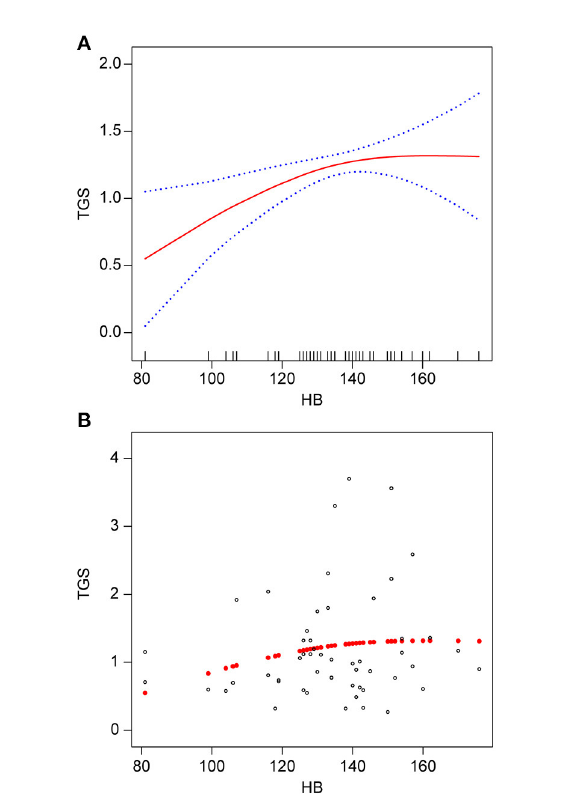
FIGURE3 Association between Hb (g/L) and TGs (mmol/L) in patients with hemorrhagic MMD. (A) smooth fitted curve of Hb and TGs, (B) scatter plot for the distribution of Hb and TGs. The solid red line represents the smooth curve fit between the variables. The blue bands represent the 95% CI of the fit. The model was adjusted for age; smoking status; alcohol consumption; BMI; disease type; TC; HDL-C; LDL-C; VLDL-C; and